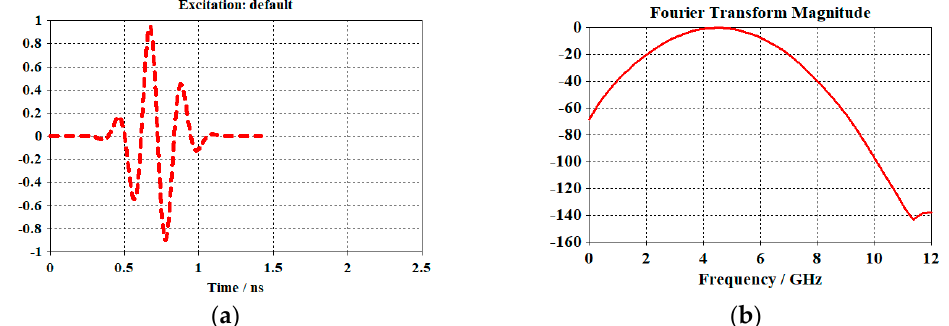
Figure 14. ( a ) The antenna input signal in CST; ( b ). antenna input signal spectrum.